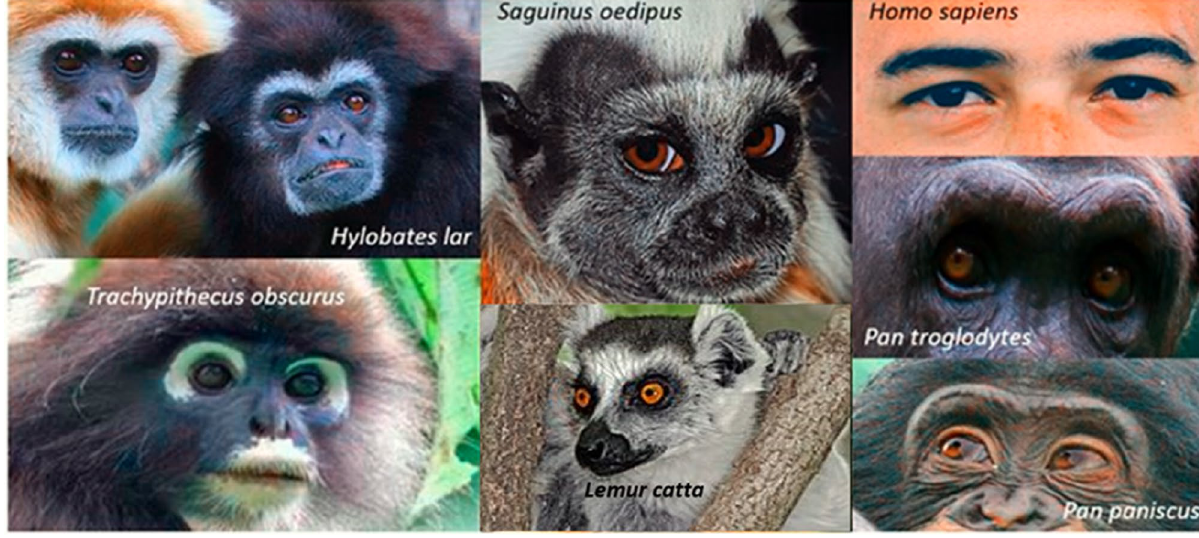
Figure 1. Ocular diversity in the primate order. H. lar photo under creative commons usage, credit to user: MatthiasKabel (https:// commo ns. wikim edia. org/ wiki/ Hylob atida e#/ media/ File: Hylob ates_ lar_ pair_ of_ white_ and_ black_ 02. jpg). T. obscurus photo under creative commons usage, credit to Lip Kee Yap (https:// commo ns. wikim edia. org/ wiki/ File: Trach ypith ecus_ obscu rus. jpg). S. oedipus photo under creative commons usage, credit to Michael Gäbler (https:// en.m. wikip edia. org/ wiki/ File: Sagui nus_ oedip us_ (Linna eus,_ 1758). jpg). L. catta photo under creative commons usage, credit to Charles J. Sharp (https:// commo ns. wikim edia. org/ wiki/ File: Ring- tailed_ lemur_ (Lemur_ catta)_ in_ tree. jpg). H. sapiens photo is in the public domain, credit to Fernanda Latronica (https:// www. pexels. com/ photo/ close- up- photo graphy- of- beard ed- man- 713520/). P.